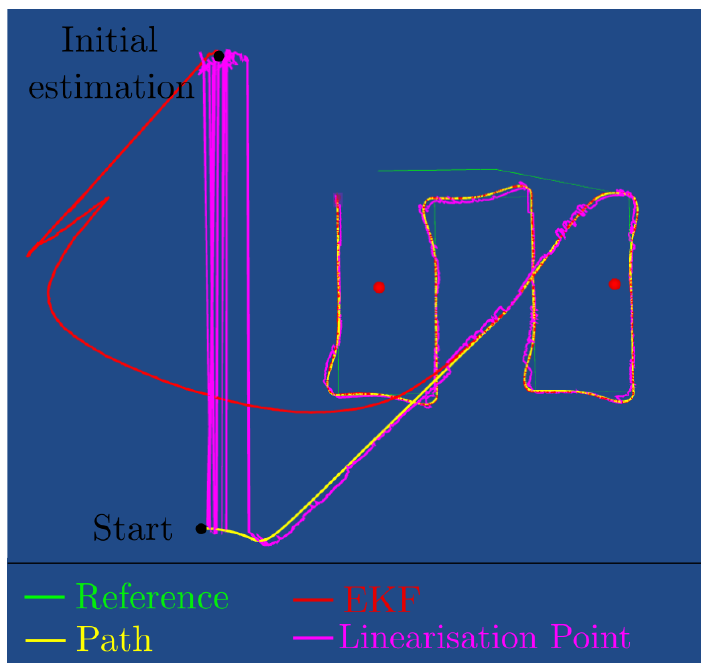
Figure 9. Scenario 2 with modified extended Kalman